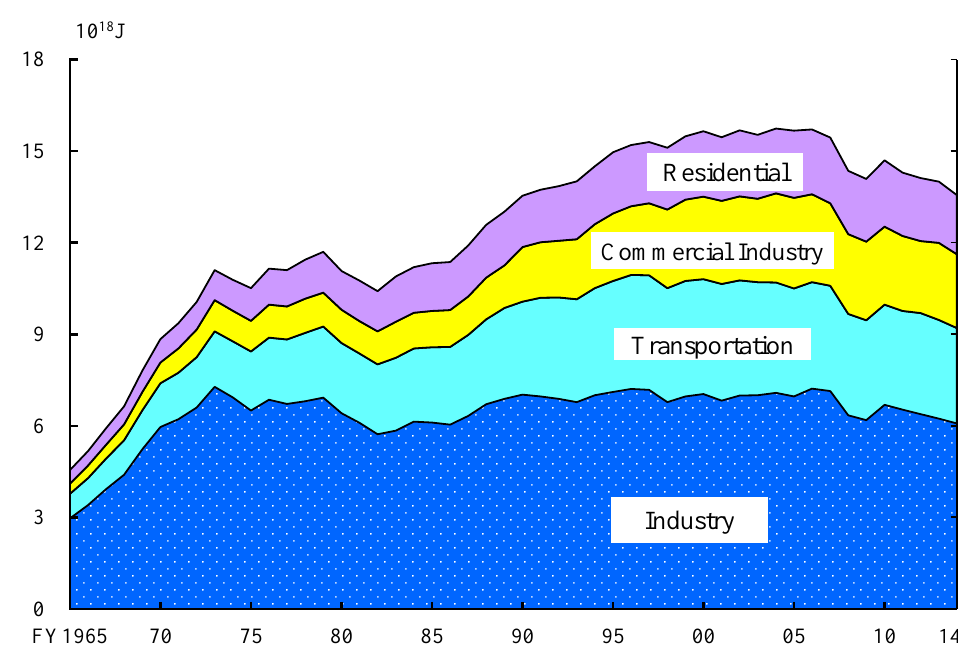
Total Final Energy Consumption by Country (2014)